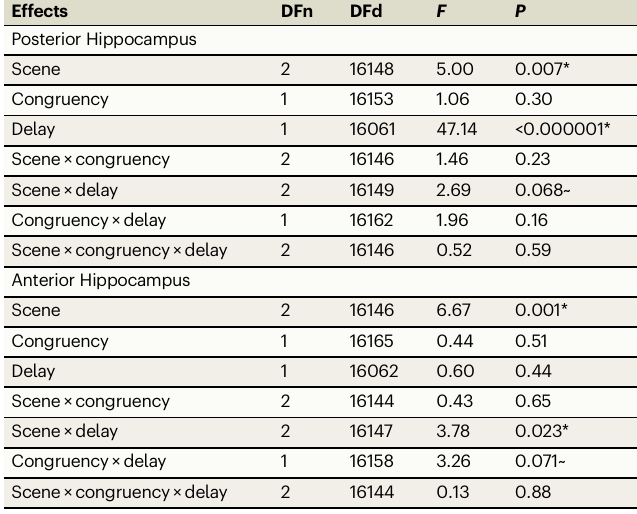
Table 1 | Results of hippocampal pattern similarity models